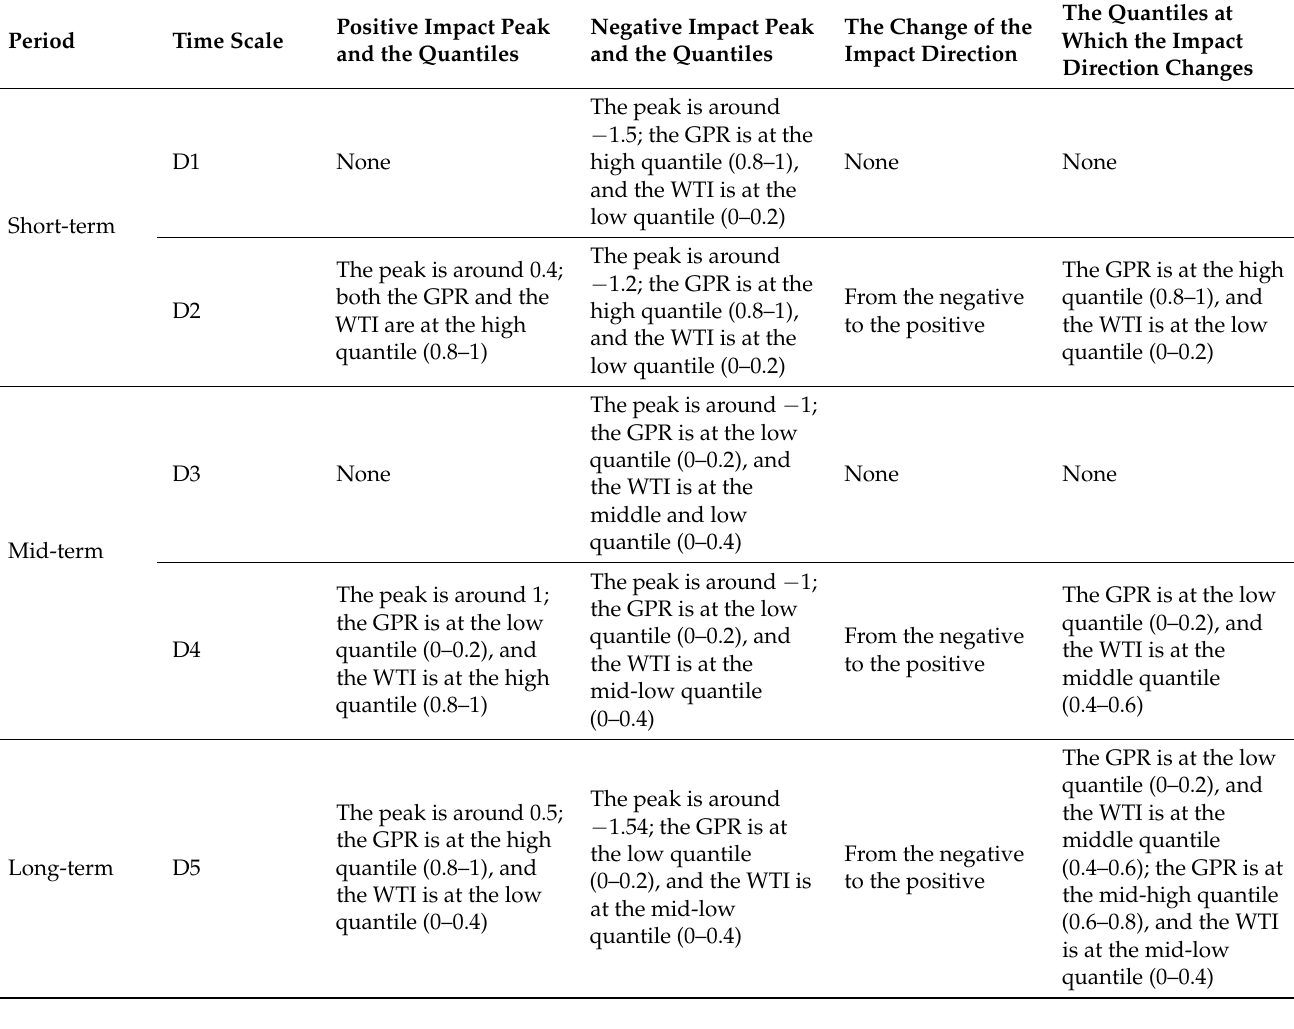
Table 4. Comparison of the impact characteristics of the GPR on the WTI at different time